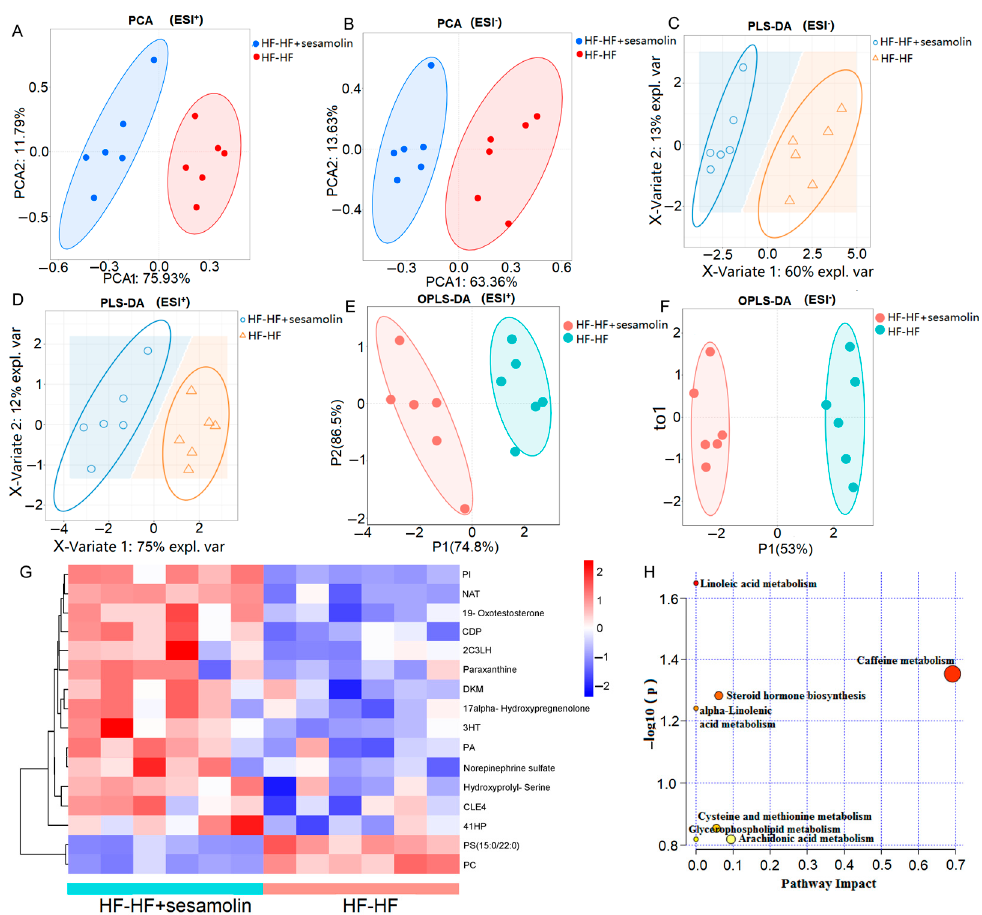
Figure 6. Untargeted metabolomics of the serum metabolomes in the HF ‐ HF group and the HF ‐ HF + sesamolin group. ( A , B ) PCA score plot; ( C , D ) PLS ‐ DA score plot; ( E , F ) OPLS ‐ DA score plot; ( G ) Heatmap of the significantly different metabolites (VIP > 1.0, and p < 0.05 with 95% confidence in ‐ tervals): (PA(15:0/18:4(6Z,9Z,12Z,15Z))) PA, (2 ‐ (3 ‐ Carboxy ‐ 3 ‐ (methylammonio)propyl) ‐ L ‐ histidine)